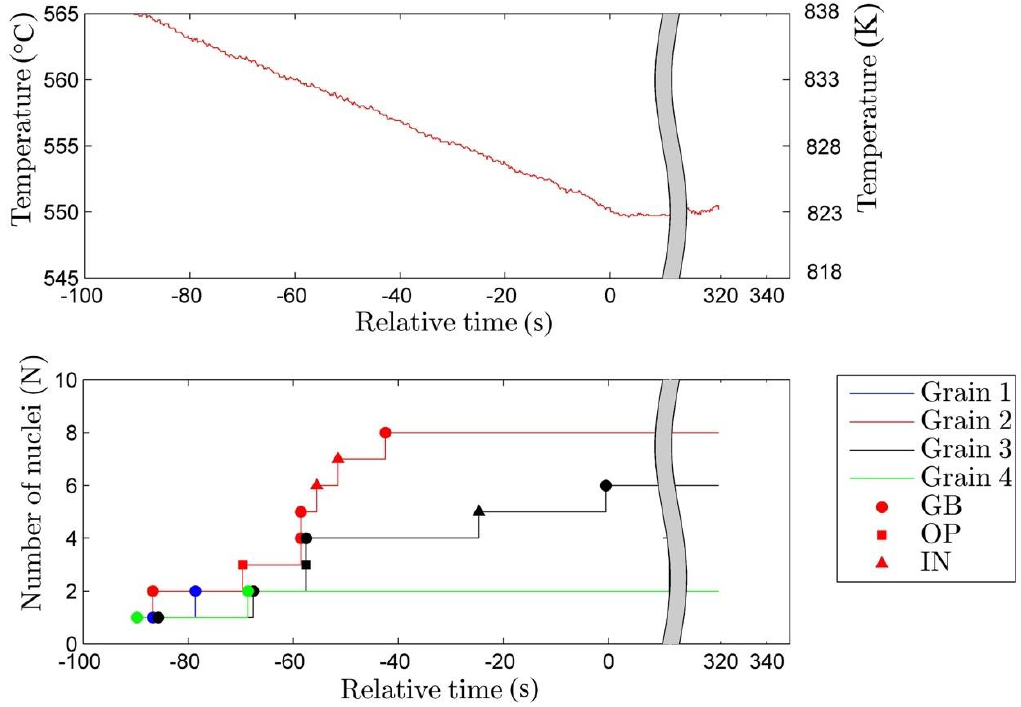
Figure 5. Temperature and nucleation sequence versus time of bainitic ferrite plates in Fe-0.2C-1.5Mn-2.0Cr during isothermal holding treatment at 823 K (550 °C).